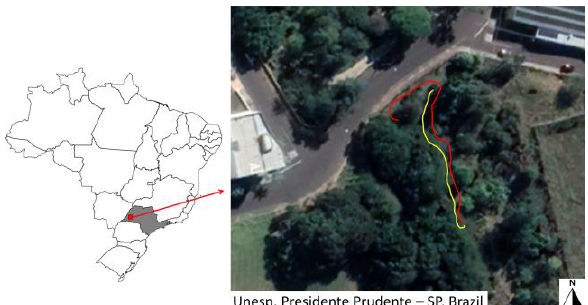
Figure 6. Location of the test area and the trajectories: the dataset I was acquired with the entire trajectory represented by both lines, and the line in yellow is the forward path (Dataset II) and in red is the backward path (Dataset